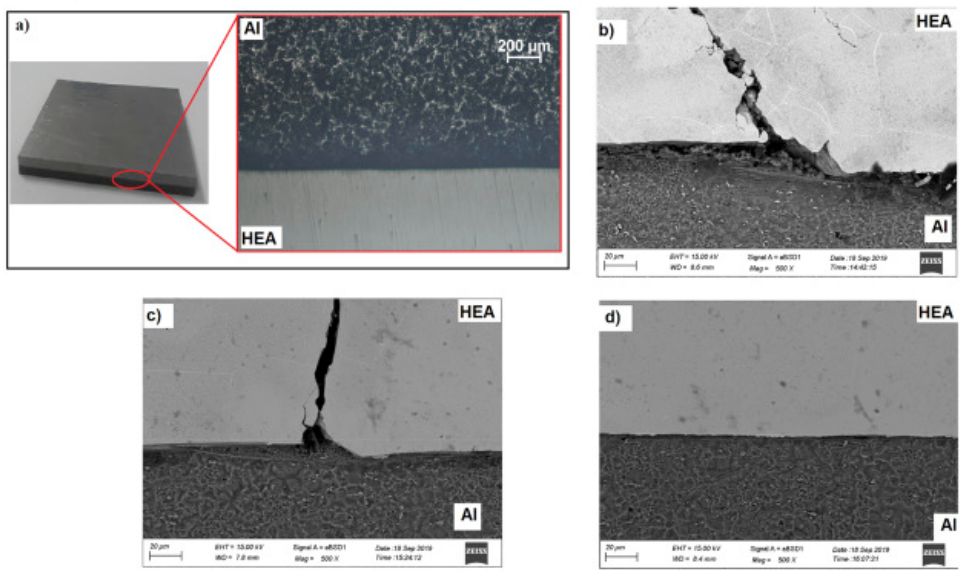
Figure 17. EW of HEA and aluminum: ( a ) optical image, ( b ) stand-off distance: 3 mm, ( c ) stand-off distance 2: mm, ( d ) stand-off distance: 1 mm. Reproduced with permission from [112]. Copyright Elsevier, 2020.